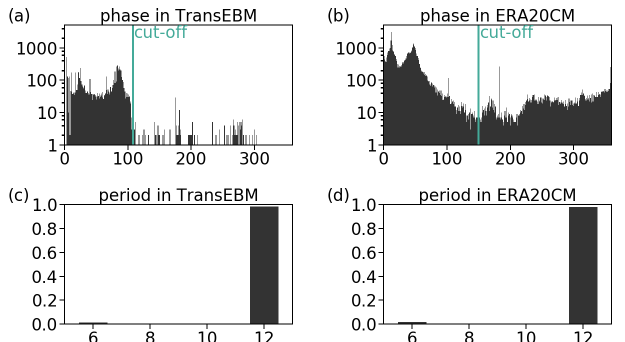
Figure C2. Logarithmic histogram of the phase distribution in (a) TransEBM and (b) ERA-20CM (Hersbach et al., 2015) with cut-offs at 108 and 150d, respectively, and histograms of the periods found in (c) TransEBM and (d) ERA-20CM. Both are based on the sinusoids fitted to the detrended 1900–1989CE time series. Model configuration as in Fig. 5. Panel (a) shows a clear cut-off, after which only few grid boxes have larger phase lags. All of them lie close to the Equator, where the time series is not sinusoidal as shown in Figs. 12a and C1a. (b) In the ERA-20CM data a much larger variety of phases occurs and even very large phase lags are found. The cut-off here was chosen such that all locations close to the Equator with non-sinusoidal behavior were excluded. Many of the locations with very large phase lags are in Antarctica, where the temperature maximum sometimes occurs a couple of days before the insolation maximum as shown in Figs. 12b and C1b. Panels (c) and (d) both show that most grid boxes have a period of around 12 months, with very few exceptions of places where the fitted sine has a period of about